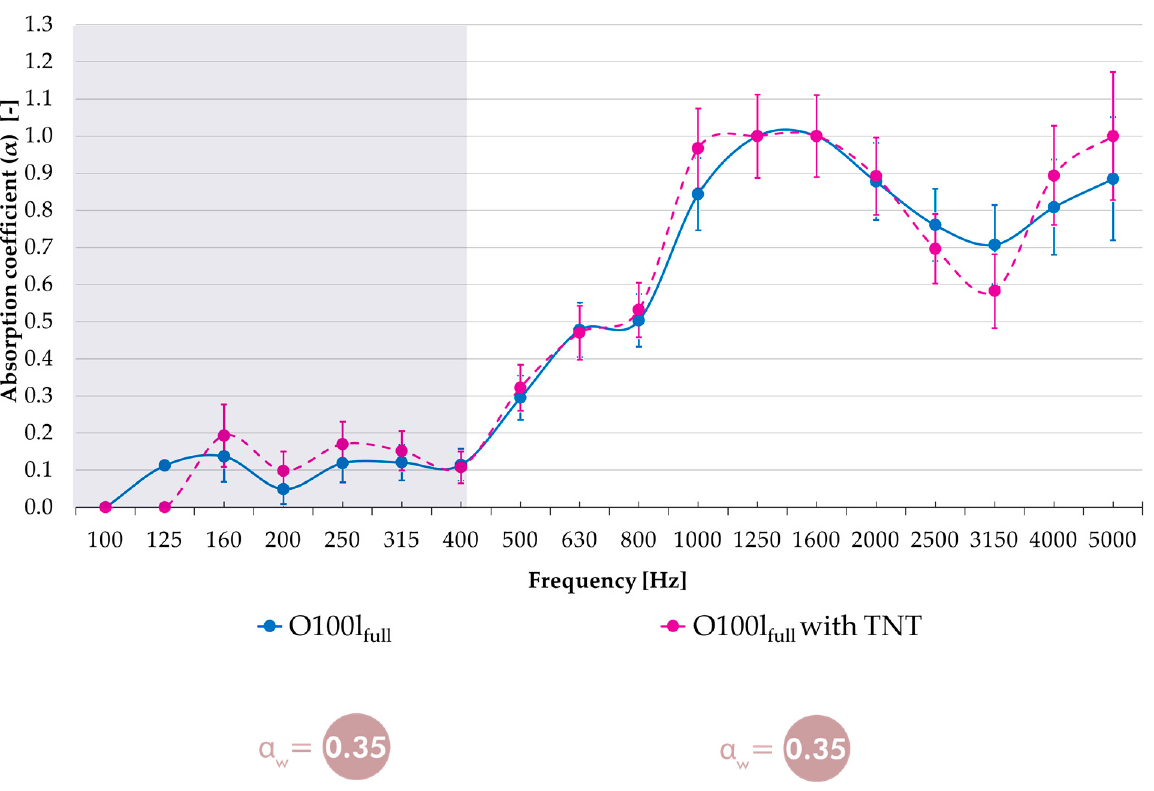
Figure 15. The obtained random incidence sound absorption coefficients from O100l full and O100l full with TNT and the standard deviations.